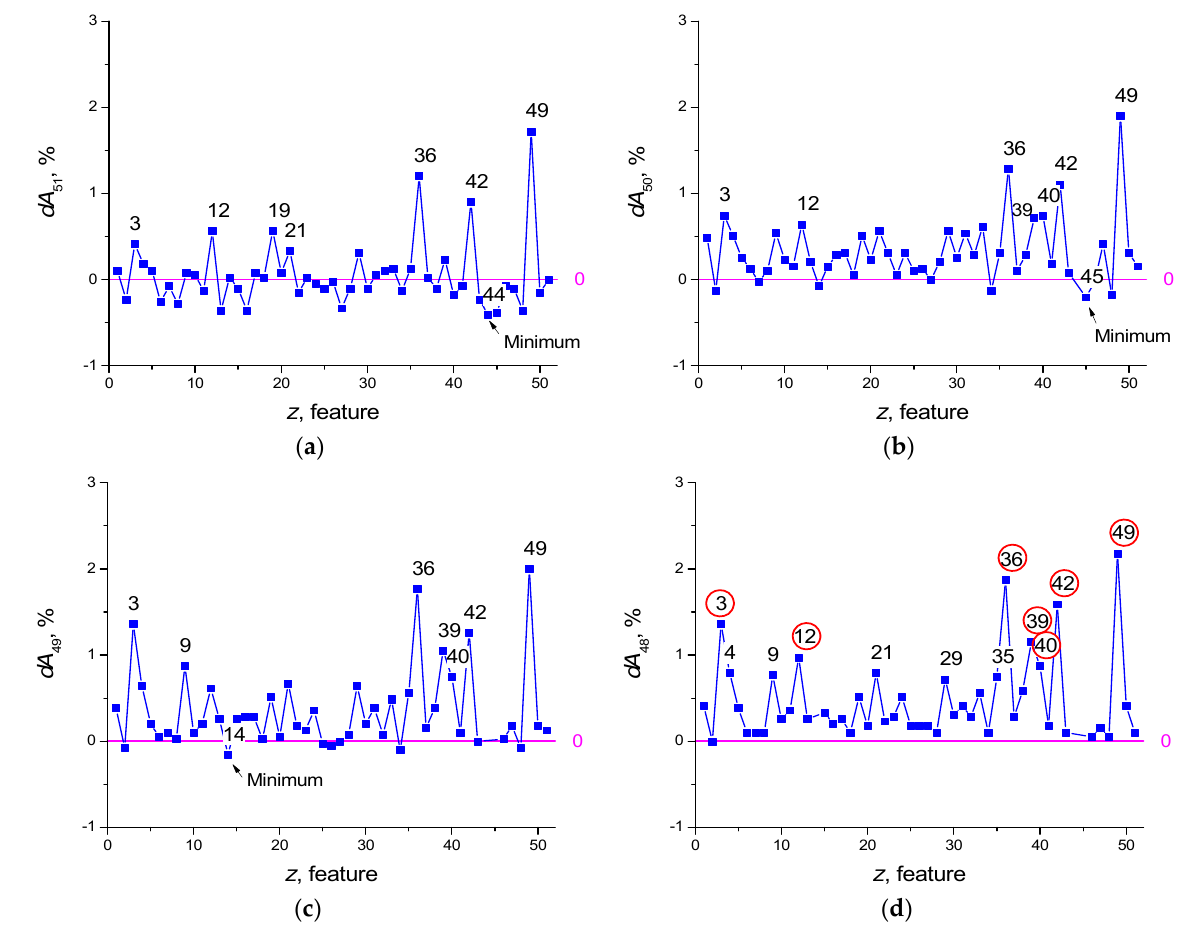
Figure 3. Function of the feature strength dA 51 ( z ) ( a ), dA 50 ( z ) ( b ), dA 49 ( z ) ( c ), dA 48 ( z ) ( d ). Dependence dA ( z ) is a function of the feature strength. The value A 50 ( FR [z]) character- izes the classification accuracy of the neural network using NF = 50 features, after deleting the feature with number z . Positive feature strength dA 51 (Figure 3a and Equation (5)) means that the removal of the feature reduces the classification accuracy of the network and the feature is useful. Negative dA 51 means that the feature interferes with learning network. After the first selection iteration, the seven most useful features can be